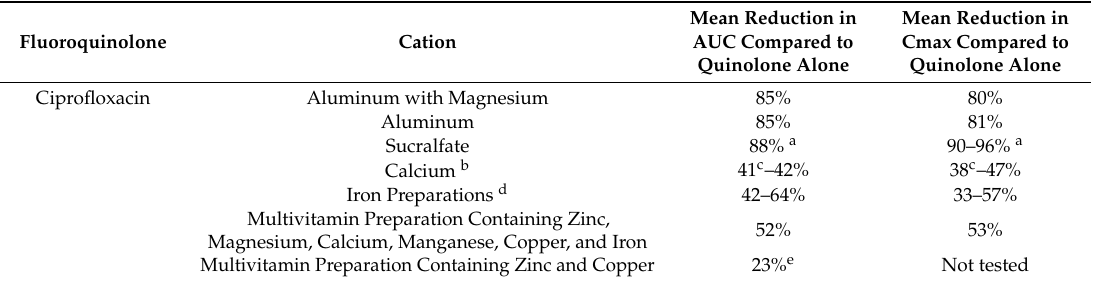
Table 1. Reported area under the concentration-time curve (AUC) and peak concentration